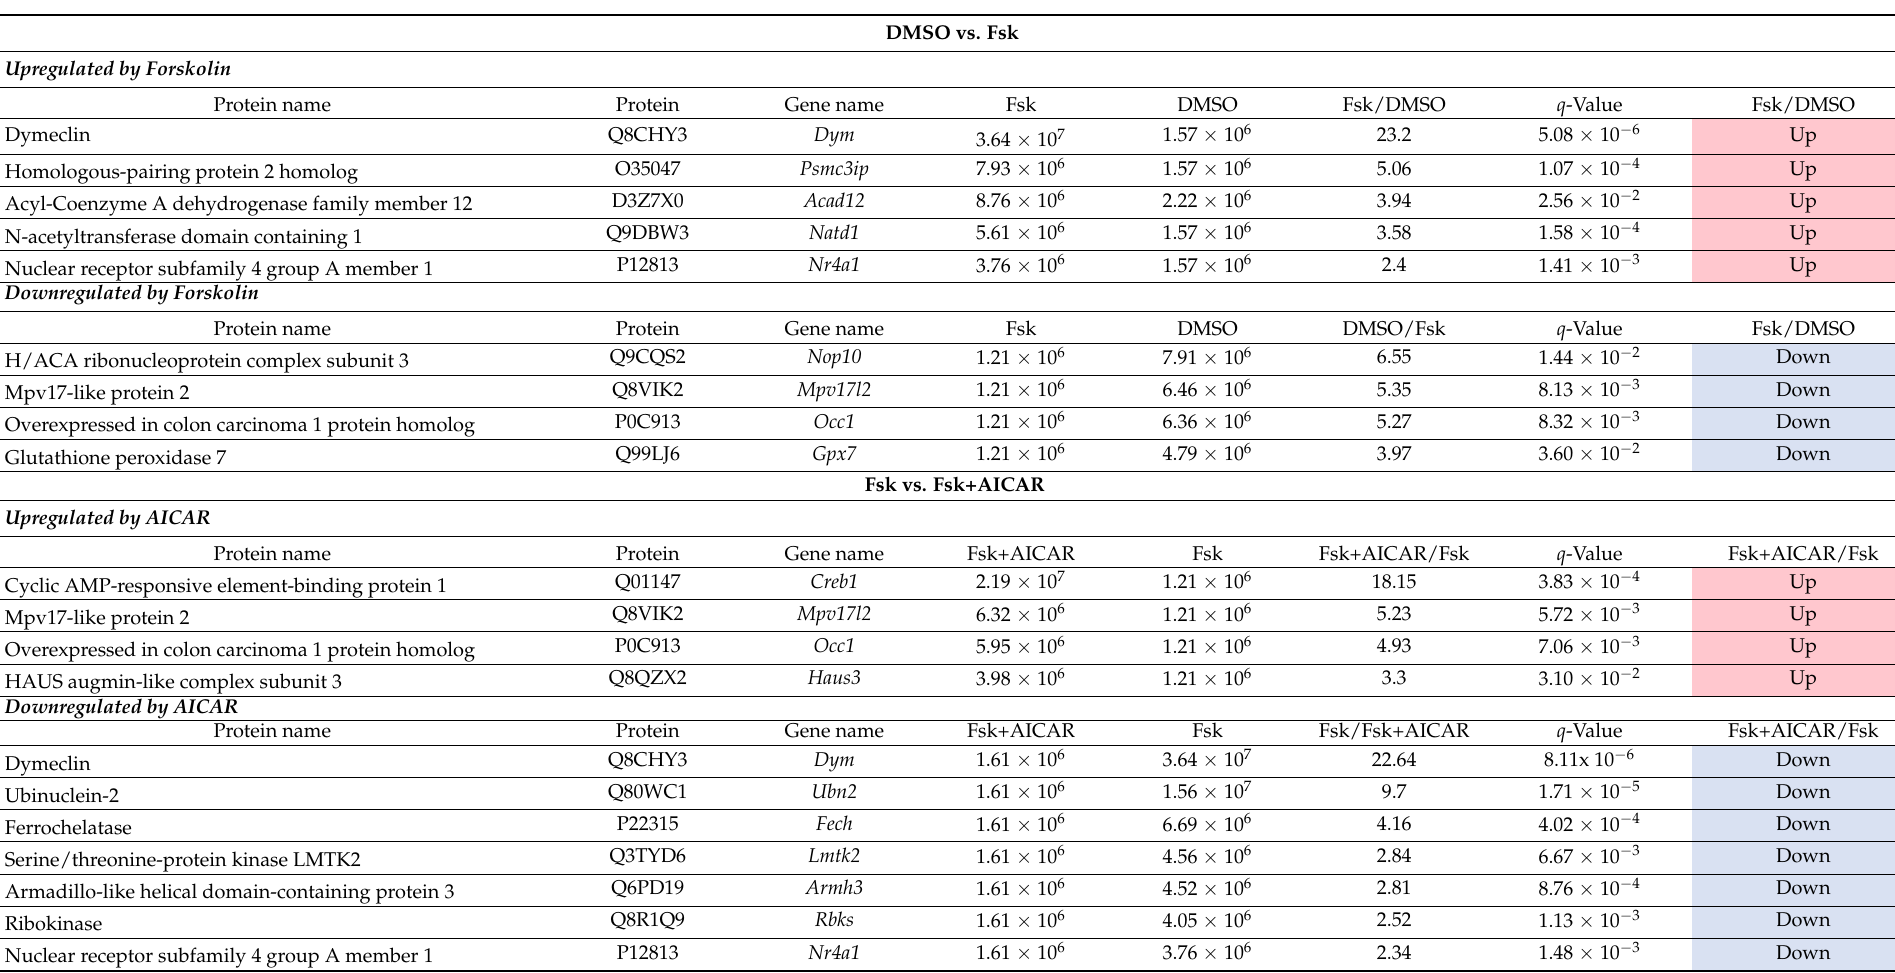
Table 1. Variation in protein levels from MA-10 Leydig cells treated for 1 h with vehicle (DMSO), Fsk, or Fsk+AICAR. DMSO vs.